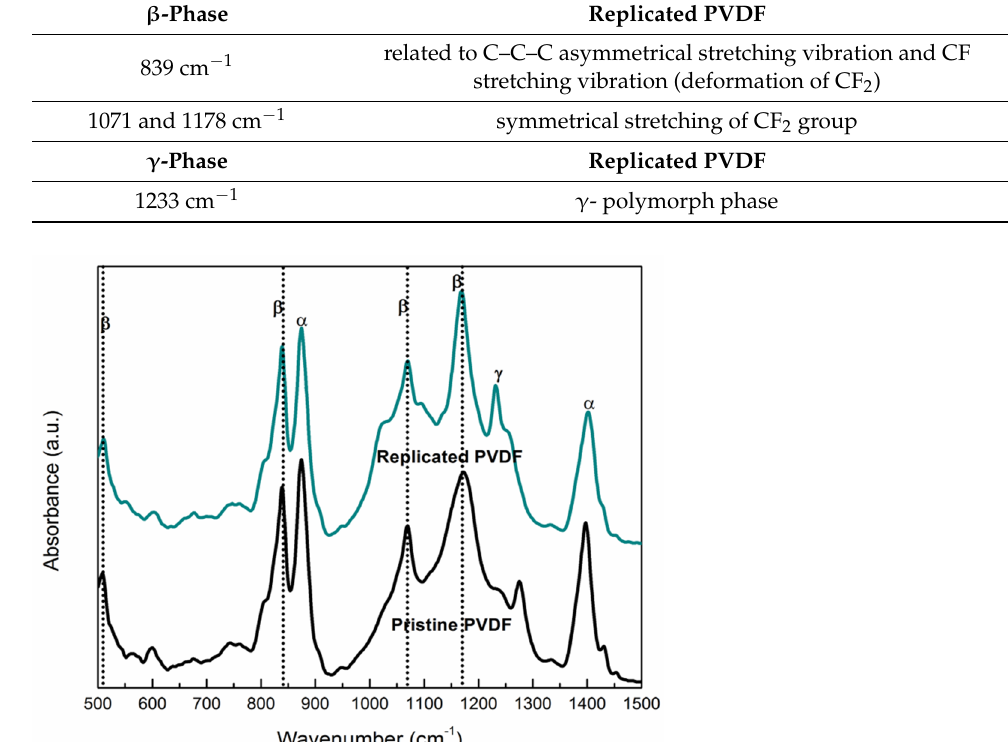
Figure 3. X-Ray photoelectron spectroscopy (XPS) wide survey spectra scan: Pristine PVDF (black line) and Replicated PVDF (colored line) . For Pristine PVDF, strong peaks attributable to F1s, O1s, and C1s were found. Fur- ther, we found no significant differences result of the XPS measurements onto replicated PVDF. In addition, we analyzed the high-resolution spectra to identify the different groups, on the polymer surface, of C1s core-level, represented in Figure 3. To intuitively show if the inherent hydrophobic character of the Pristine PVDF scaffolds is suffering some changes after thermal annealing treatment (4 h at 60 °C), the carbon atomic percent- age in total was quantitatively calculated according to the peak areas where the charac- teristics peaks are highlighted. In the Pristine PVDF the main peaks are centered at 289.4 eV (due to CH2-CF2-CH2), 284.8 eV (due to CF2-CH2-CF2), 283.4 eV (CH) [35–37] and for 286.98 eV for (COO) represented in Figure 4A. Similar results were obtained for